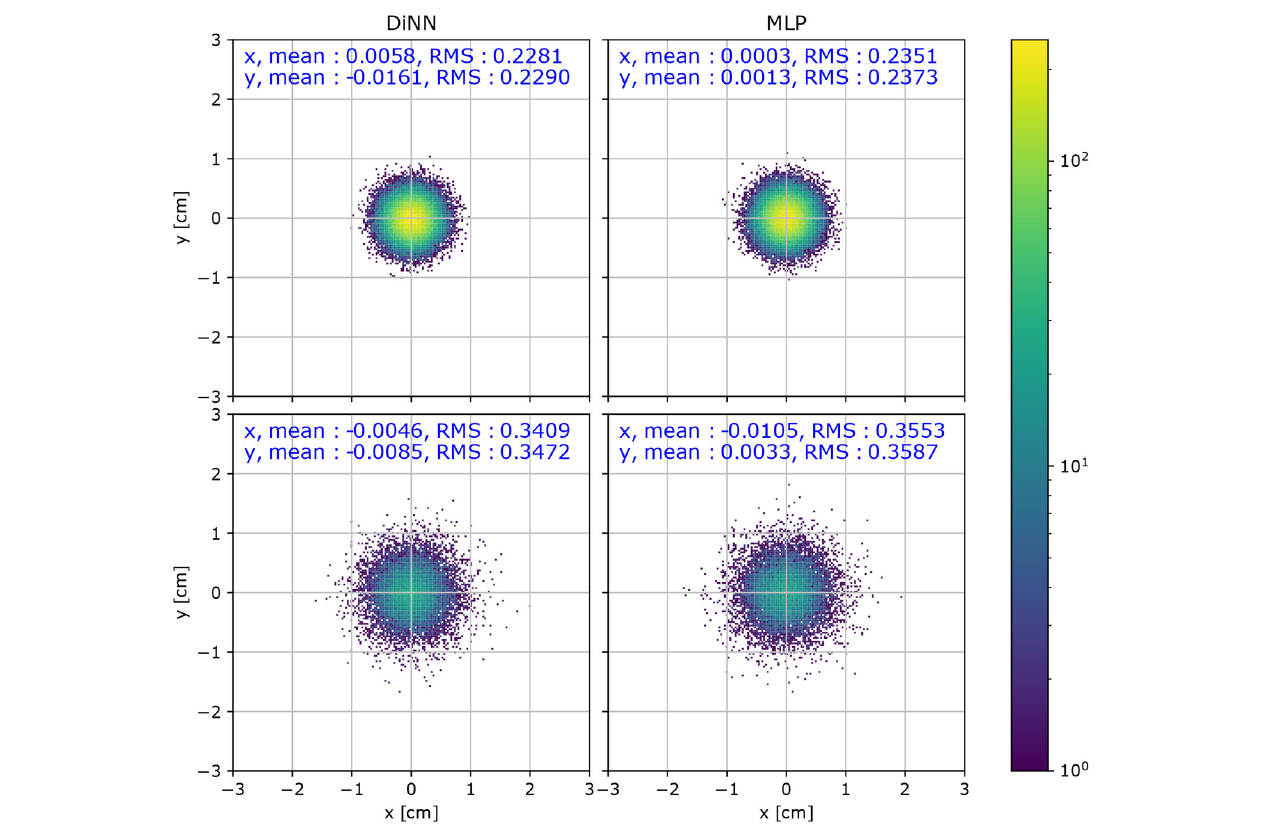
FIGURE 7 | Distribution of localization error, ˆE x − E x , for a test set of simulated 100 electron S2 signals. S2 signals with R < 60 cm (top) have a smaller RMS than interactions with R < 60 cm (bottom).